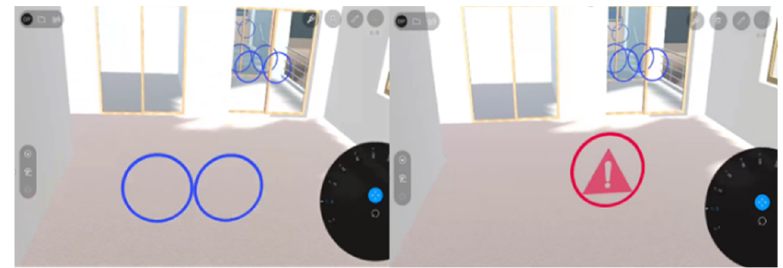
Figure 9. Implementation of toggling function.